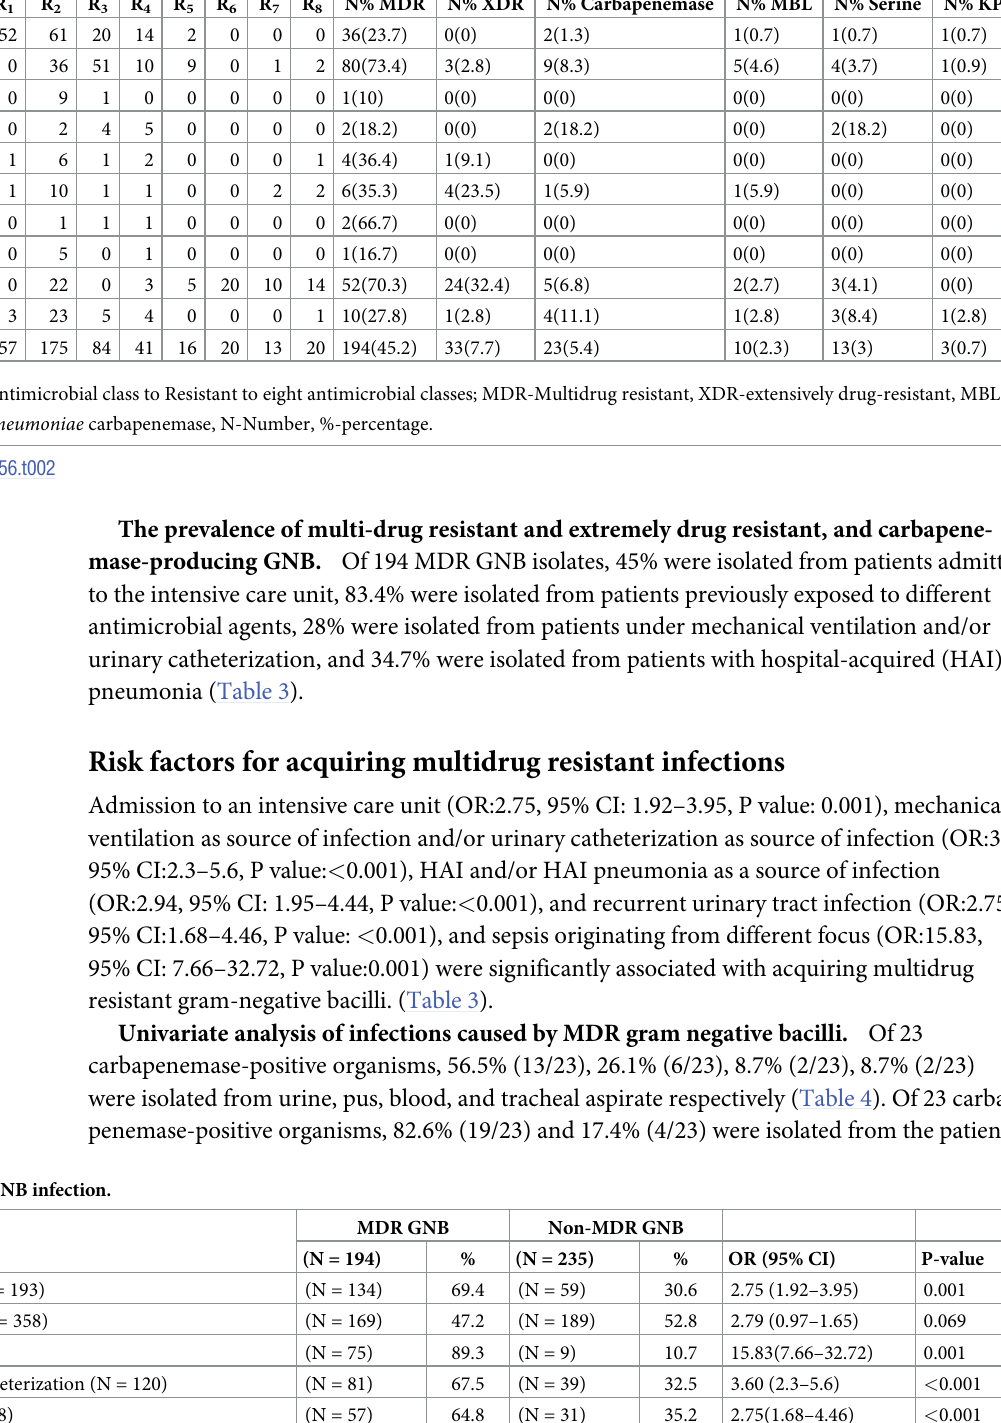
Table 2. Prevalence of multidrug resistance and extremely drug resistant, and carbapenemase-producing GNB against 8 antimicrobial classes. Organisms